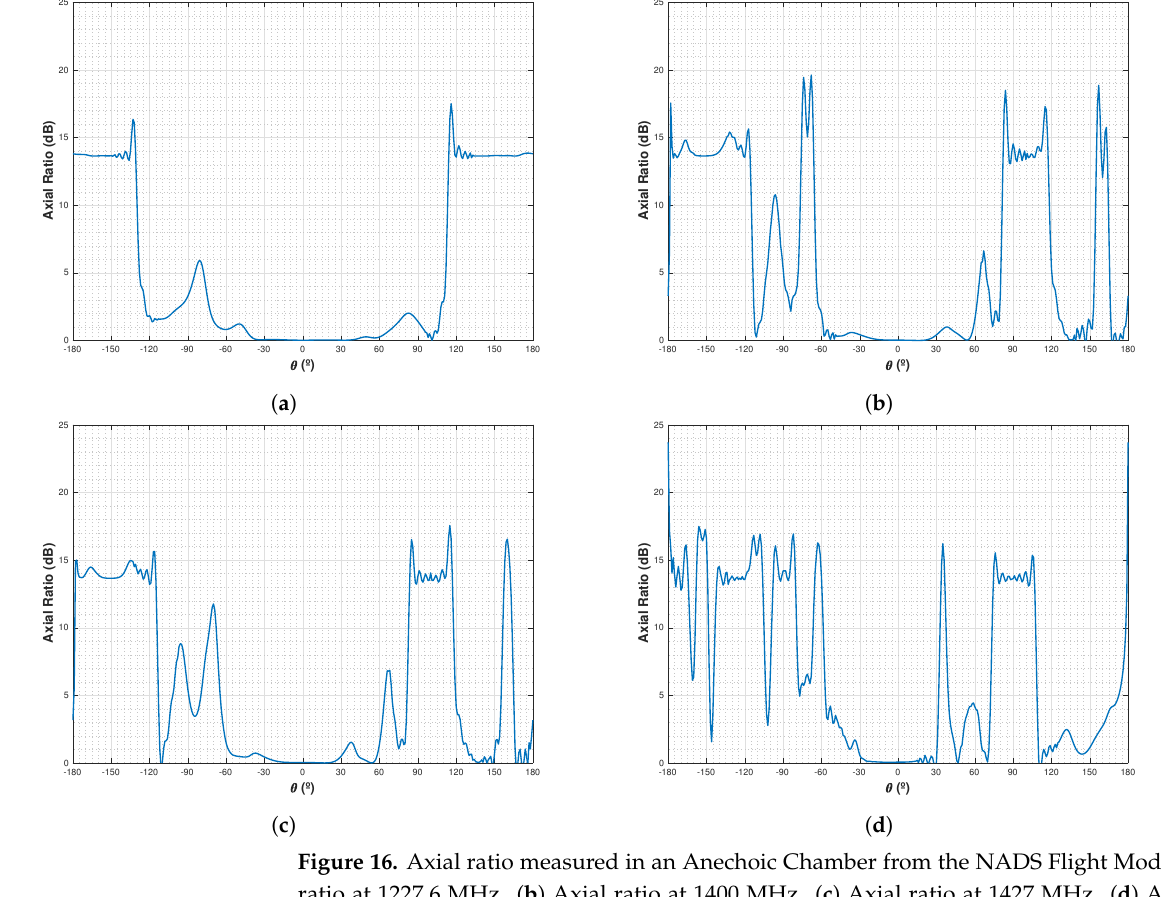
Figure 16. Axial ratio measured in an Anechoic Chamber from the NADS Flight Model. ( a ) Axial ratio at 1227.6 MHz. ( b ) Axial ratio at 1400 MHz. ( c ) Axial ratio at 1427 MHz. ( d ) Axial ratio at 1575